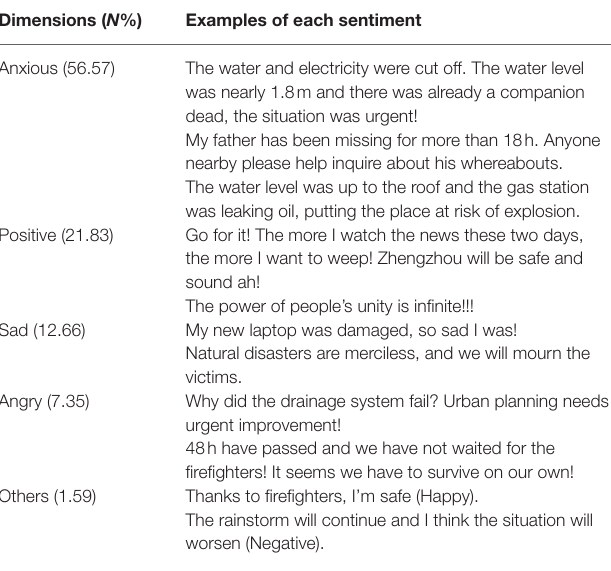
TABLE 2 | The affective flows in online collaborative